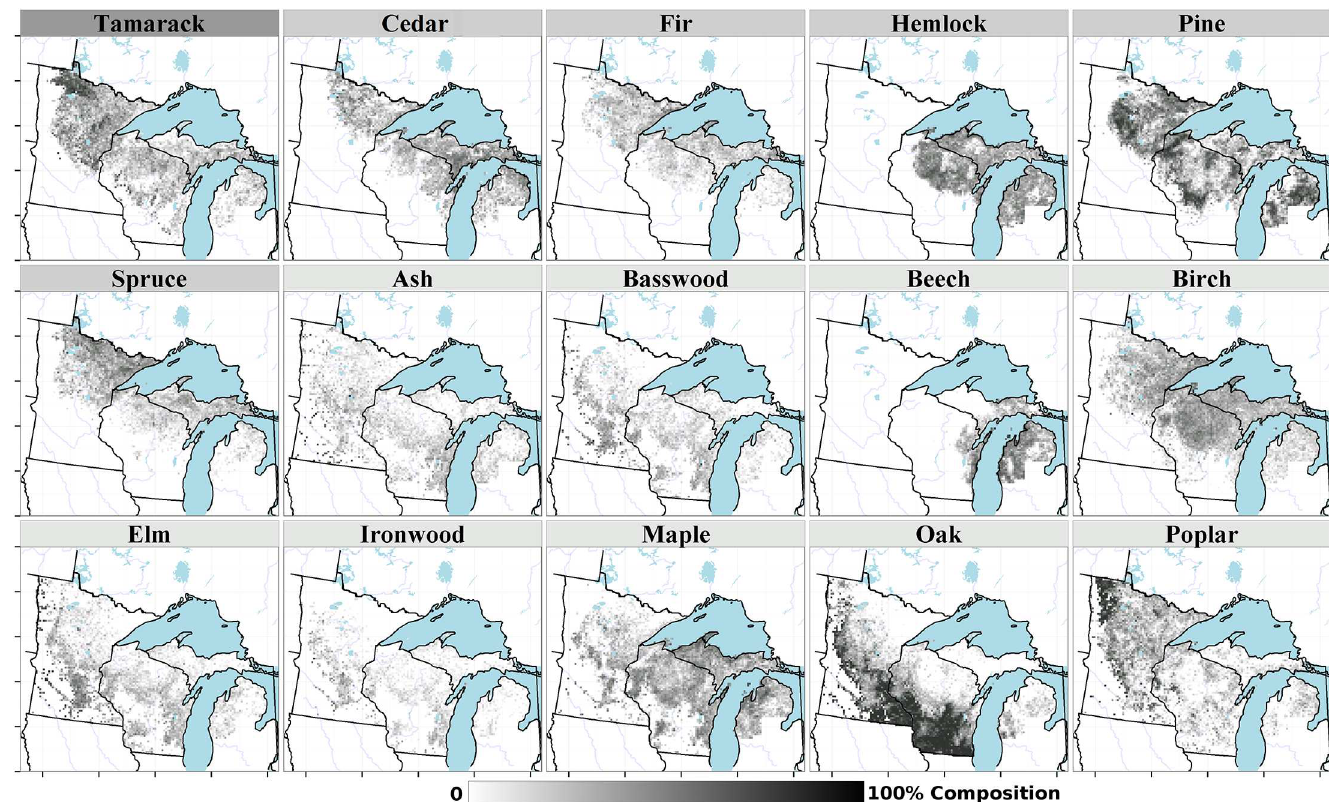
Fig 4. Forest composition (%, using stem density) for the 15 most abundant tree taxa in the PLSS. The scale is drawn using a square-root transform to emphasize low abundances. Shadingof the bar above individual taxon maps indicatesplant functionaltype assignments (dark gray: needleleaved deciduous; light gray: needleleaved evergreen;white: broadleaved